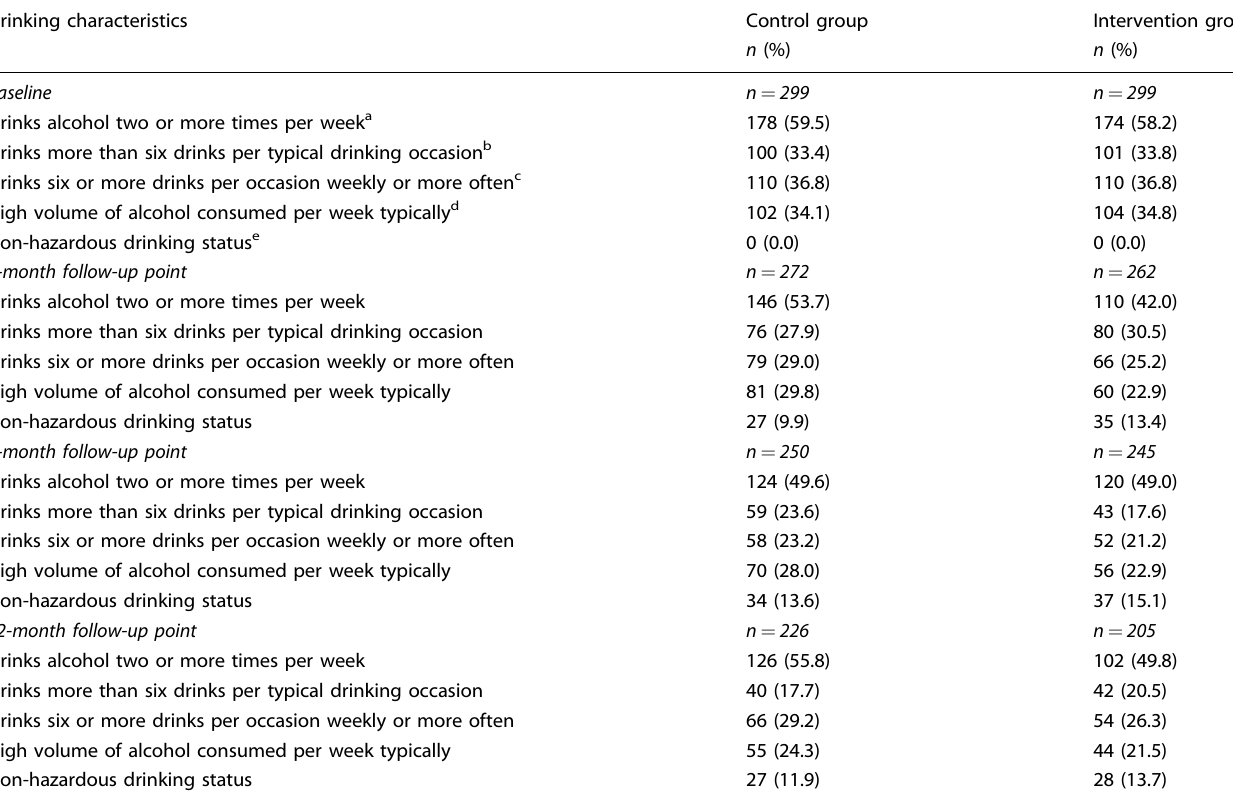
Table 2. Drinking characteristics of participants at baseline and follow-up time points